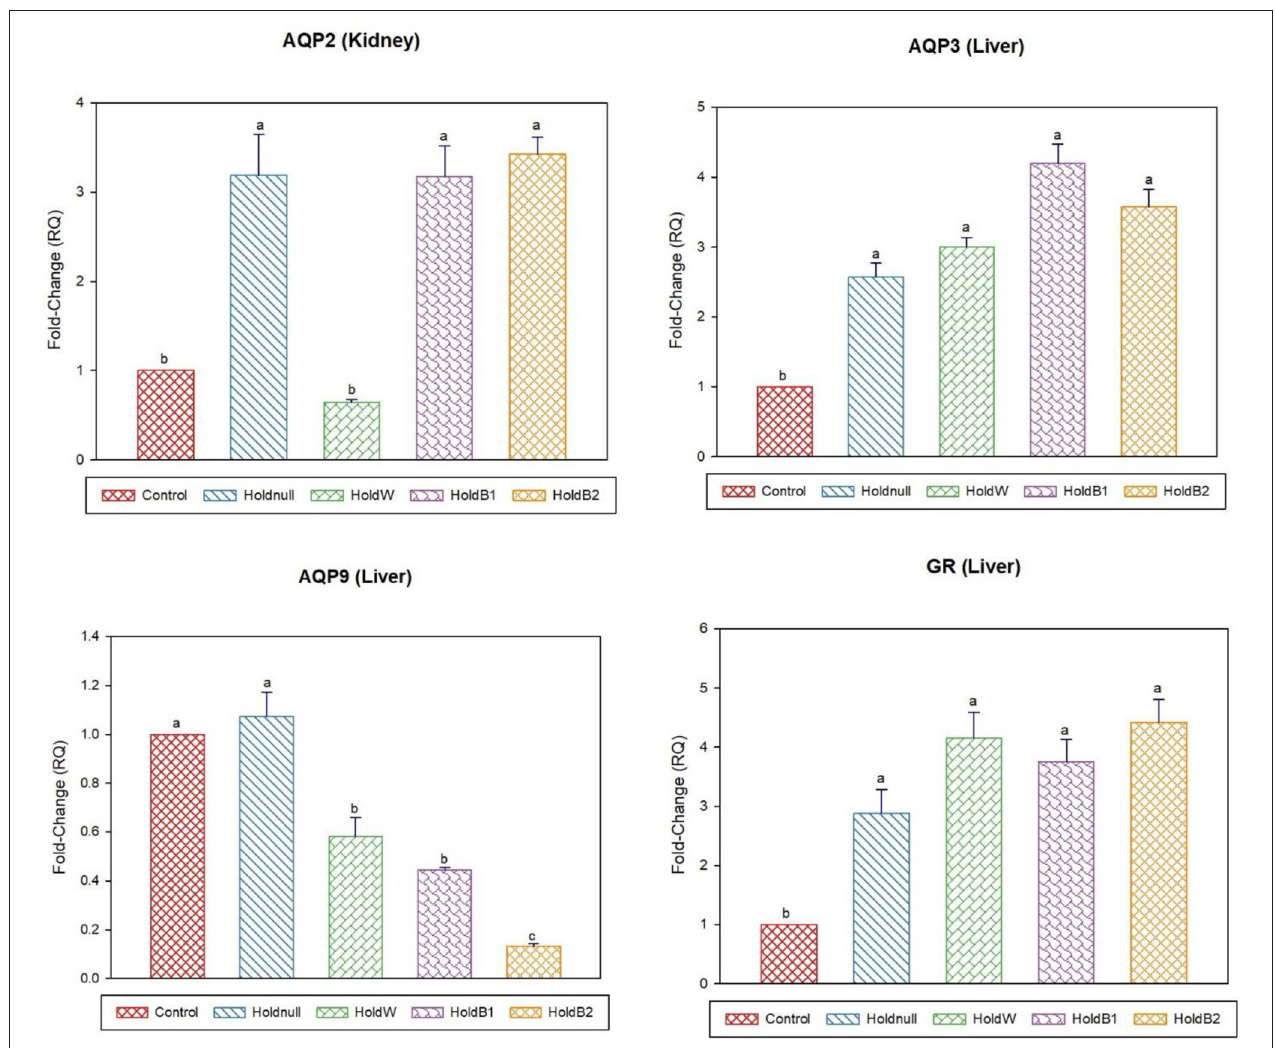
FIGURE 6 | Effect of betaine on the relative expression (fold-change or RQ) of AQP3, AQP9, GR in the liver, and AQP2 in the kidney of day-15 old chicks. Control, placed on feed immediately; Holdnull, holding for 48h + no access to feed or water; HoldW, holding for 48h + water only; HoldB1, holding for 48h + water supplemented with betaine (1ml per L); HoldB2, holding for 48h + water supplemented with betaine (2ml per L). Bars with different letters are significantly different ( p < 0.05). Mean ± standard error of the mean, n = 6. AQP, aquaporin; GR, glucocorticoids receptor. 2 AQP, aquaporin; GR, glucocorticoids